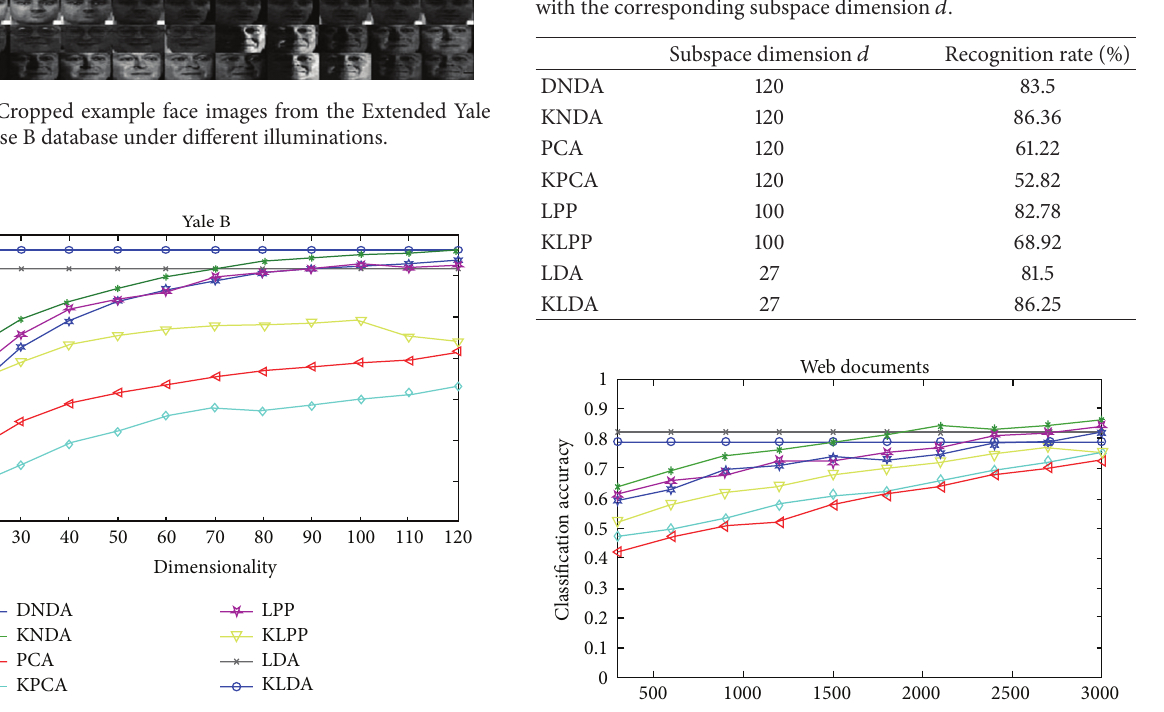
Figure 11: The recognition rates versus the subspace dimension on Extended Yale Face Database B.